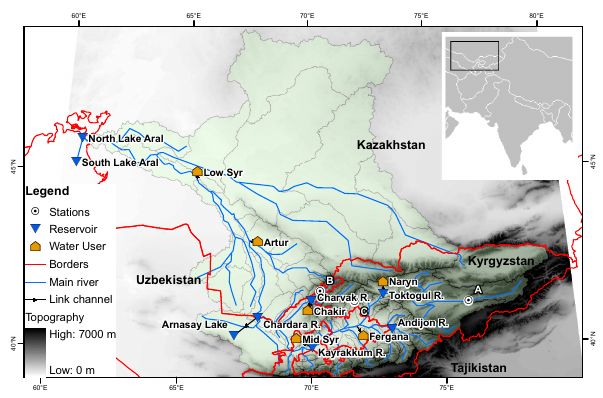
Fig. 1. Base map of the Syr Darya River Basin (SDRB).